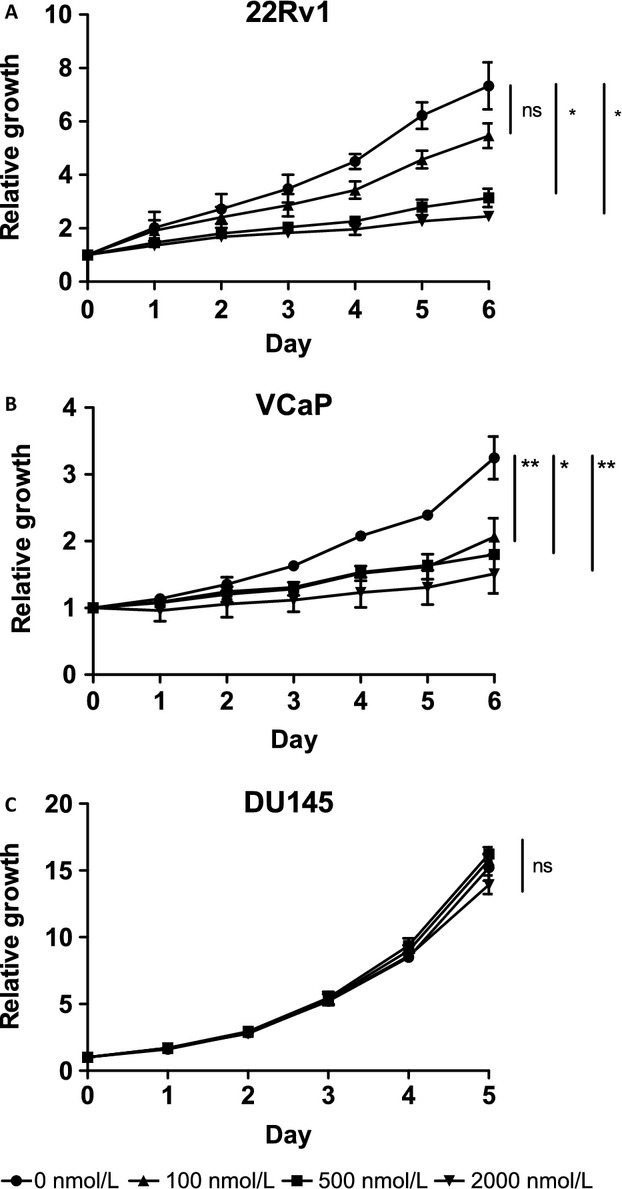
CDK 4/6 inhibitor PD0332991 suppresses the growth of (A) 22Rv1 and (B) VCaP cells but not (C) DU145 cells. Cells were treated with 0, 100, 500, and 2000 nmol/L concentrations of the inhibitor and growth was followed for 5 to 6 days. Each concentration was done in quadruplicates and each experiment was done in triplicates, averages from experiments ±SEM are shown. P-values of growth differences between different concentrations on day 5 or 6 were calculated using paired t-test, *P-value <0.05, **P-value <0.01.